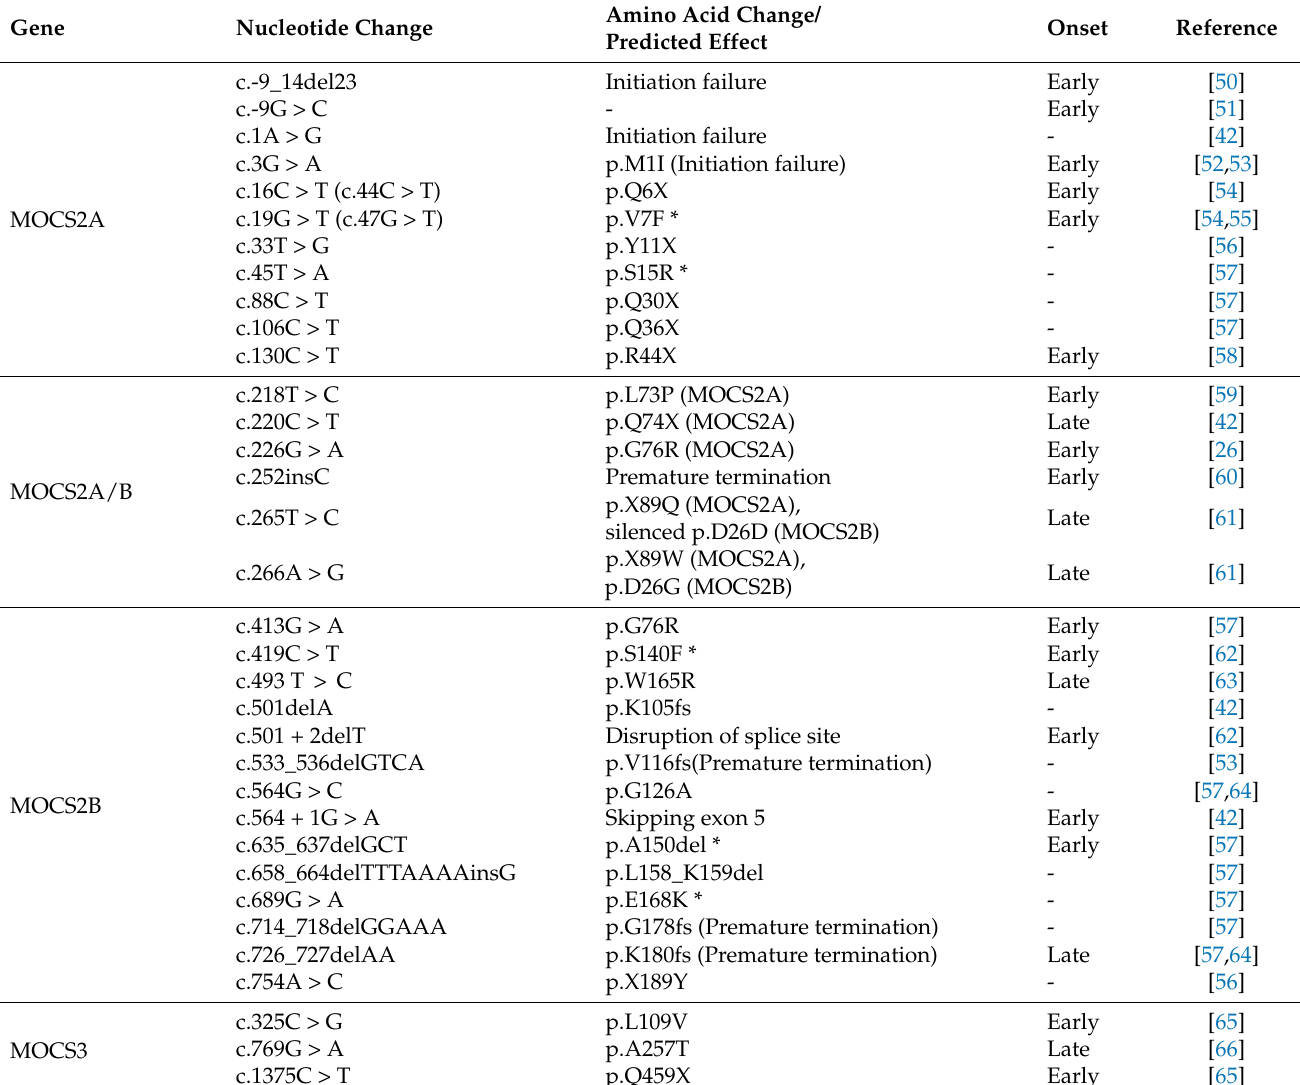
Table 1. List of MoCD type B